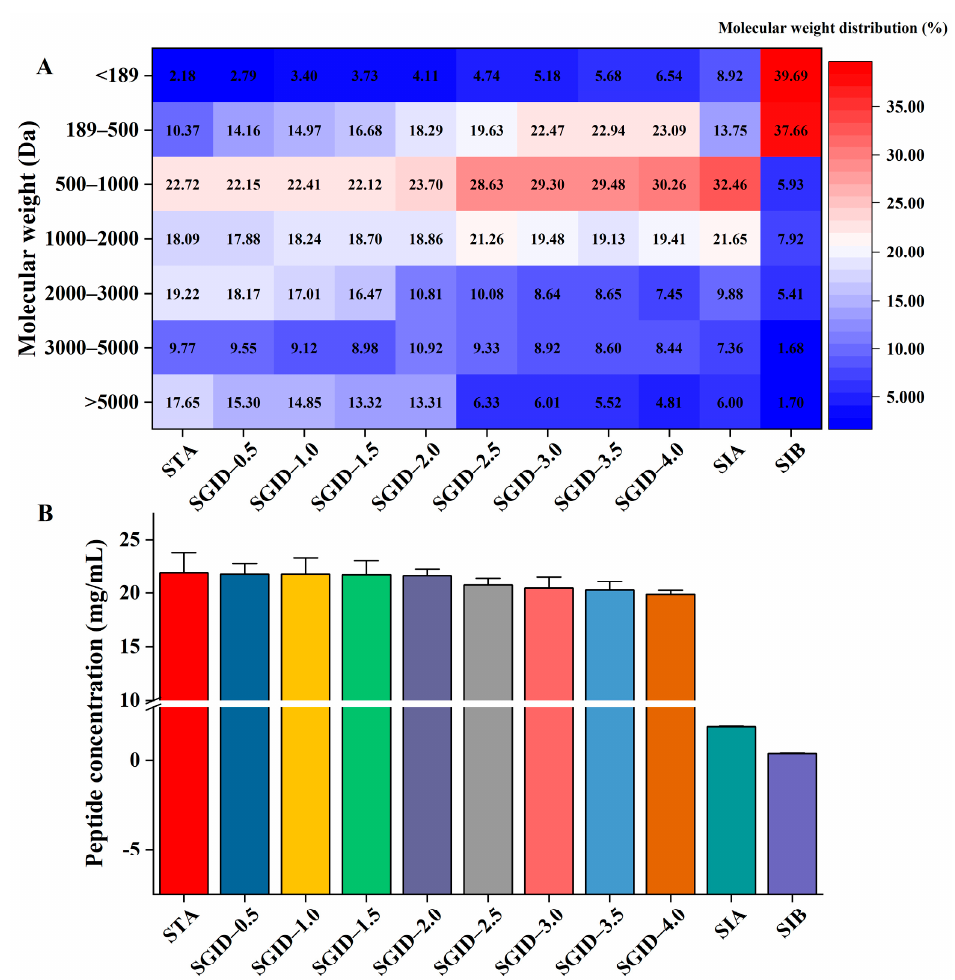
Figure 1. The alteration in the molecular weight distribution ( A ) and concentration ( B ) of peptides during the simulated gastrointestinal digestion and absorption. STA: start digestion samples; SGID-X: samples during simulated digestion and absorption, X is the time (h); SIA: samples on the apical side of the transwell cell; SIB: samples on the basolateral side of transwell cell. Through comparing the alteration in the concentration of free amino acids before and after SA, it was found that the most increased amino acid was glycine (Figure 2B). The concentration of glycine increased from 0.98 × 10 − 2 mg/mL to 5.89 × 10 − 2 mg/mL; the increase ratio was 501.02%. This was followed by proline and tyrosine, whose increase ratio was 338.46% and 234.41%, respectively. Moreover, leucine, phenylalanine, methionine, alanine, and histidine all increased by more than 100%. The free amino acid distribution on the two sides of the transwell is shown in Figure 2B. It indicates that 82.5% of the proline on the BL side. These results suggest that intestinal cells might have different transport capacities for different free amino acids in